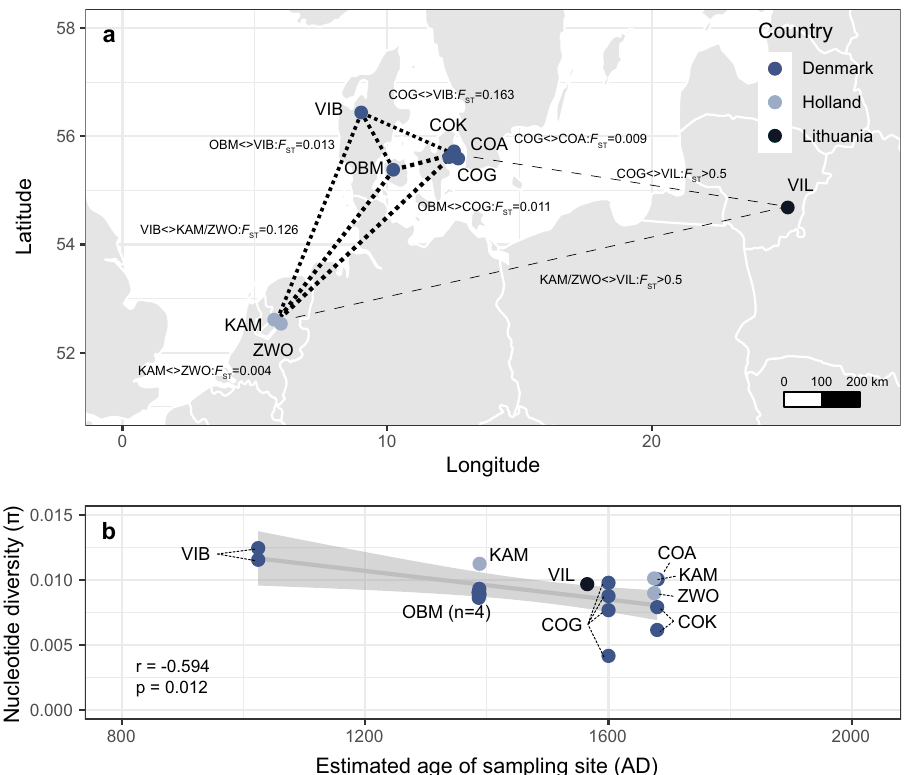
Fig. 2 Changes in ancient parasite diversity across space and time. a Genetic differentiation between ancient sample sites based on pairwise estimates of mitochondrial genome diversity (pooled sample F ST ) is shown. The width of the dashed line connecting pairs of sample sites re fl ects the degree of similarity between mitochondrial genomes. b Comparison of the levels of nucleotide diversity ( π ) within the ancient mitochondrial genomes over time. Pearson ’ s correlation (r) and associated p-value (cor.test; two-sided; adjusted p-value [ “ holm ” ]), together with the linear regression (grey trendline line) and 95% con fi dence level interval (grey shaded area), are shown. Samples are coloured based on the scheme in Fig. 1. Sample site abbreviations: COA = Adelgade, Copenhagen; COG = Gammel Strand, Copenhagen; COK = Kultorvet, Copenhagen; OMB = Odense By Midte; VIB = Viborg; KAM = Kampen; ZWO = Zwolle; VIL =